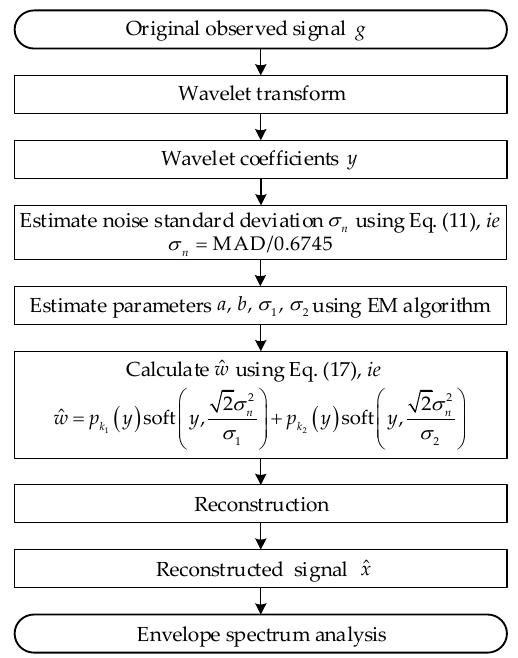
Figure 1. Flowchart of the proposed method. MAD; median absolute deviation.